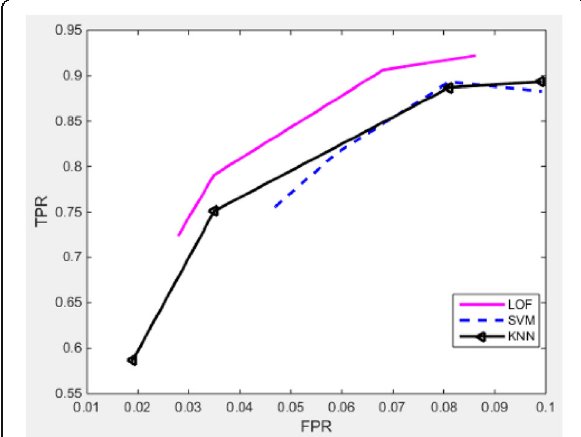
different algorithms, LOF, KNN, and SVM on test5 – test 8 datasets